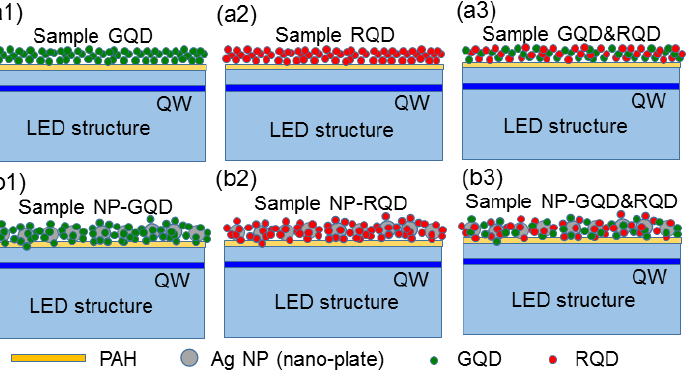
Figure 6. ( a1 ) – ( a3 ) and ( b1 ) – ( b3 ) Schematic illustrations of the surface structures of samples GQD, RQD, GQD&RQD, NP-GQD, NP-RQD, and NP-GQD&RQD,